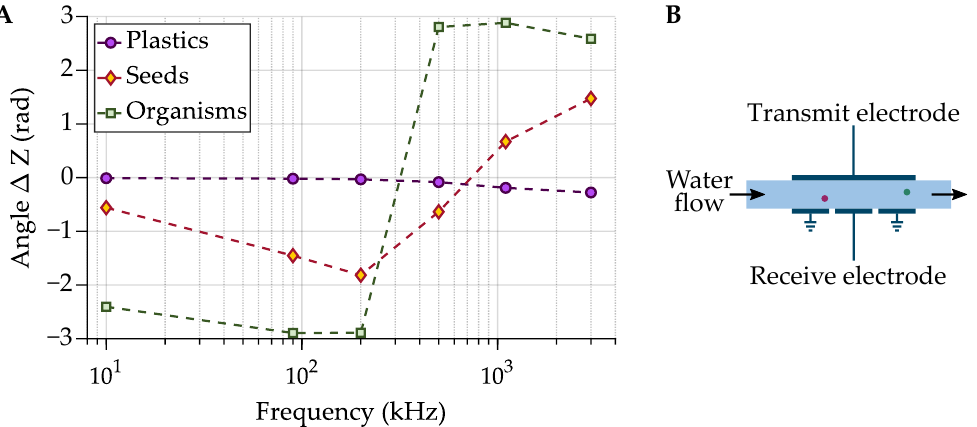
Figure 13. ( A ) The average angle of the impedance change associated with different particle types. The angle of seeds and organisms changes direction with frequency, whereas it remains small for plastics. ( B ) Diagram of the impedance measurement flow cell used